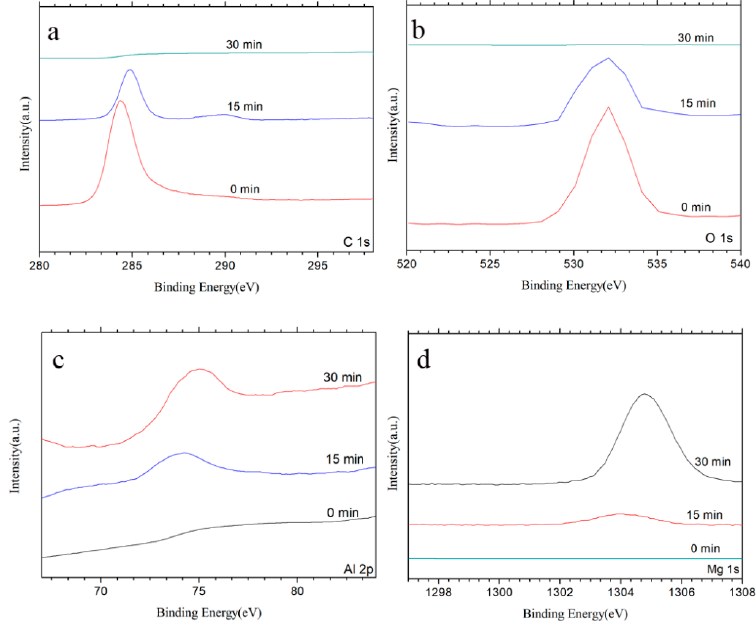
Figure 2. High-resolution XPS spectra of the treated AM60 alloy at 6 × 10 6 ions/cm 2 after sputtering for different times: ( a ) C 1 s , ( b ) O 1 s , ( c ) Al 2 p , and ( d ) Mg 1 s .